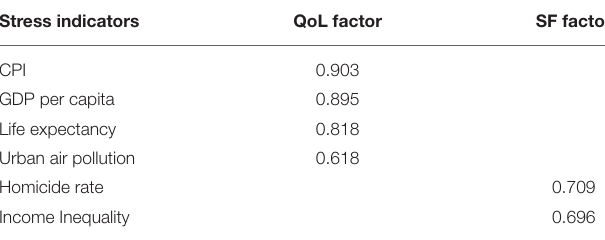
TABLE 2 | Clustering of the stress determinants by principal component analysis.